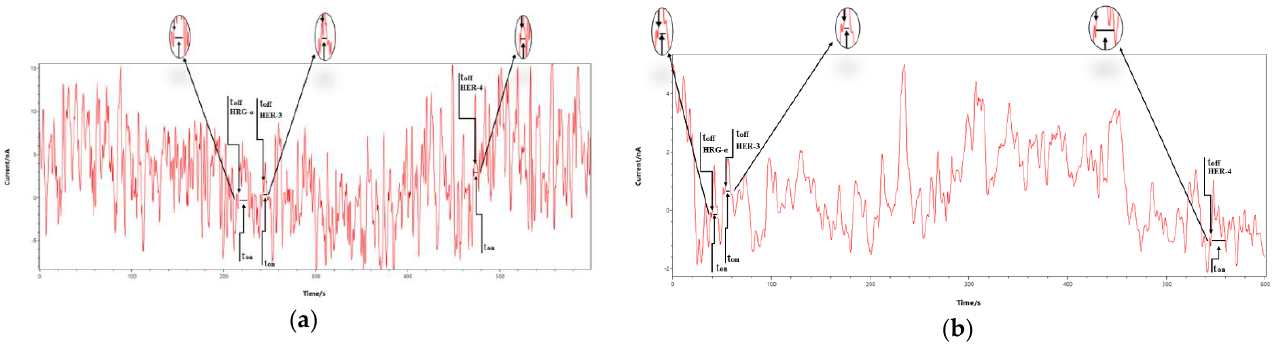
Figure 1. Pattern recognition of HRG − α , HER − 3 and HER − 4 in whole blood samples, using stochastic sensors: ( a ) MD/Gr − TiO 2 , ( b ) MD/Gr − TiO 2 − Au.